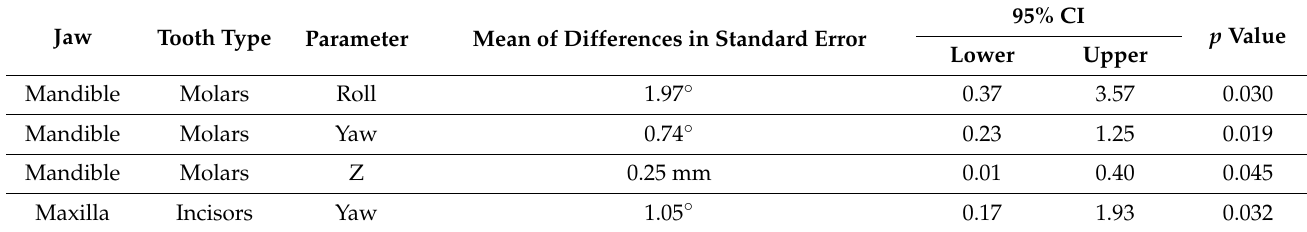
Table 4. Influence of SARME therapy on the fabrication of the setup. Only significant differences with corresponding parameter are